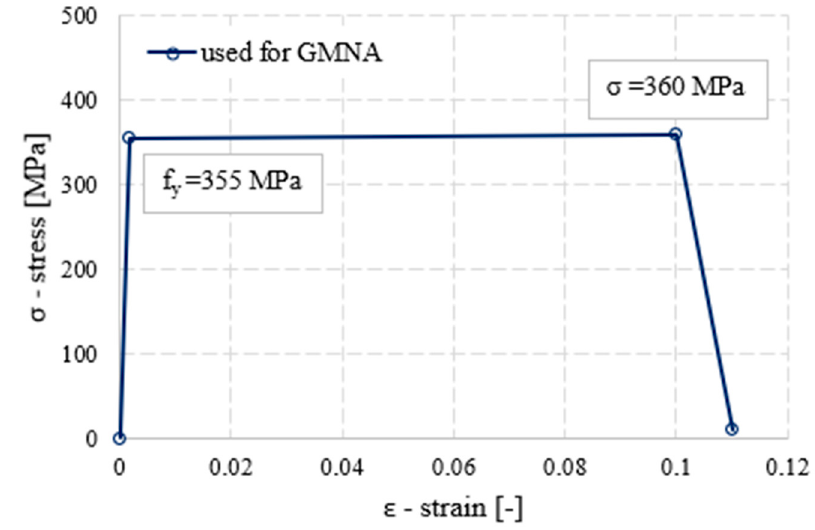
Figure 10. Multilinear stress–strain curve used in the non-linear analysis.